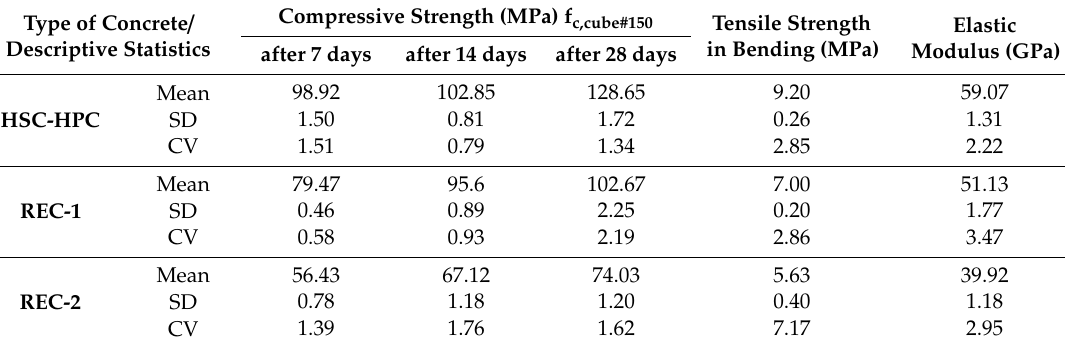
Table 9. Characteristics of the recycled aggregate concrete and the HSC-HPC